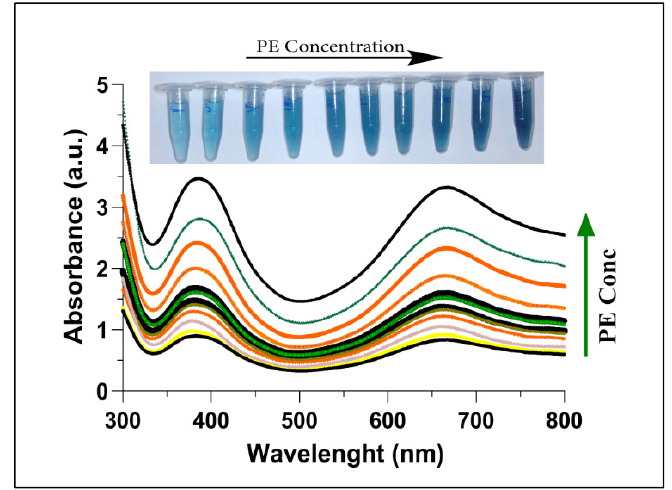
Figure 5. UV-Vis absorption spectra of AChE + Ach + C-AuNPs + TMB plotted with increasing concentrations of PE (0–400 nM). The increase in PE concentration leads to less aggregation of C-AuNPs, thus a stronger catalysed colorimetric reaction with deeper colour from oxTMB. The inset shows the colour of the corresponding reaction mixtures.